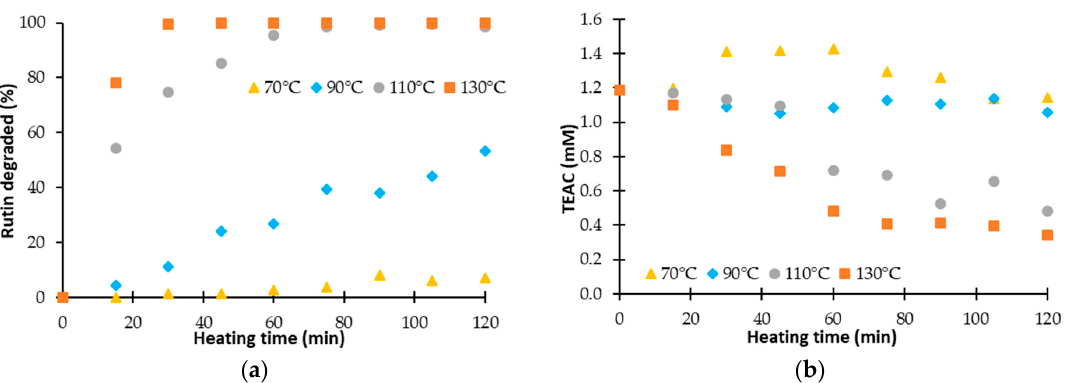
Figure 2. ( a ) Percentage of degraded rutin during a heat treatment and ( b ) evolution of the Trolox Equivalent Antioxidant Capacity (TEAC).